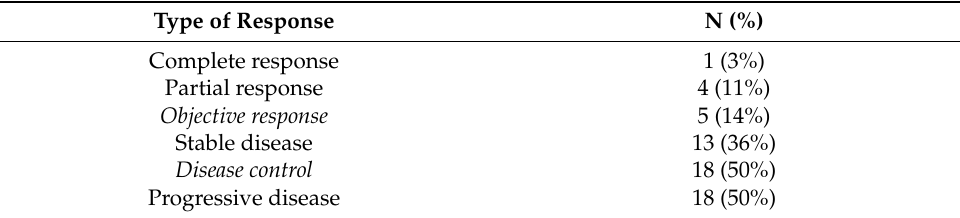
Table 4. Response evaluation (RANO criteria).